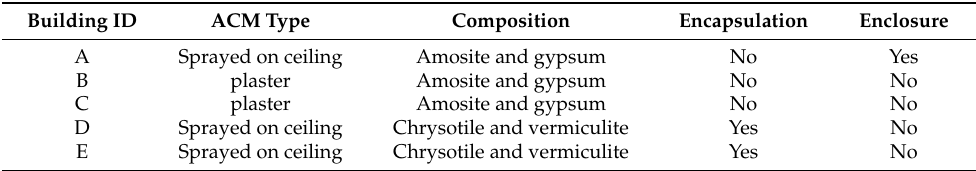
Table 1. Type of friable ACM present in each building, composition of asbestos-containing mixture and abatement method